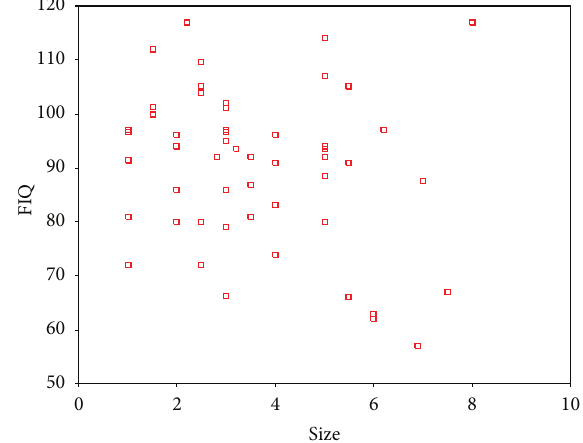
Figure 7: Partial correlation analysis showed a negative relation between tumor size and IQ in the intracerebral subgroup. Corre- lation coefficient was − 0.383 ( 𝑃 = .005